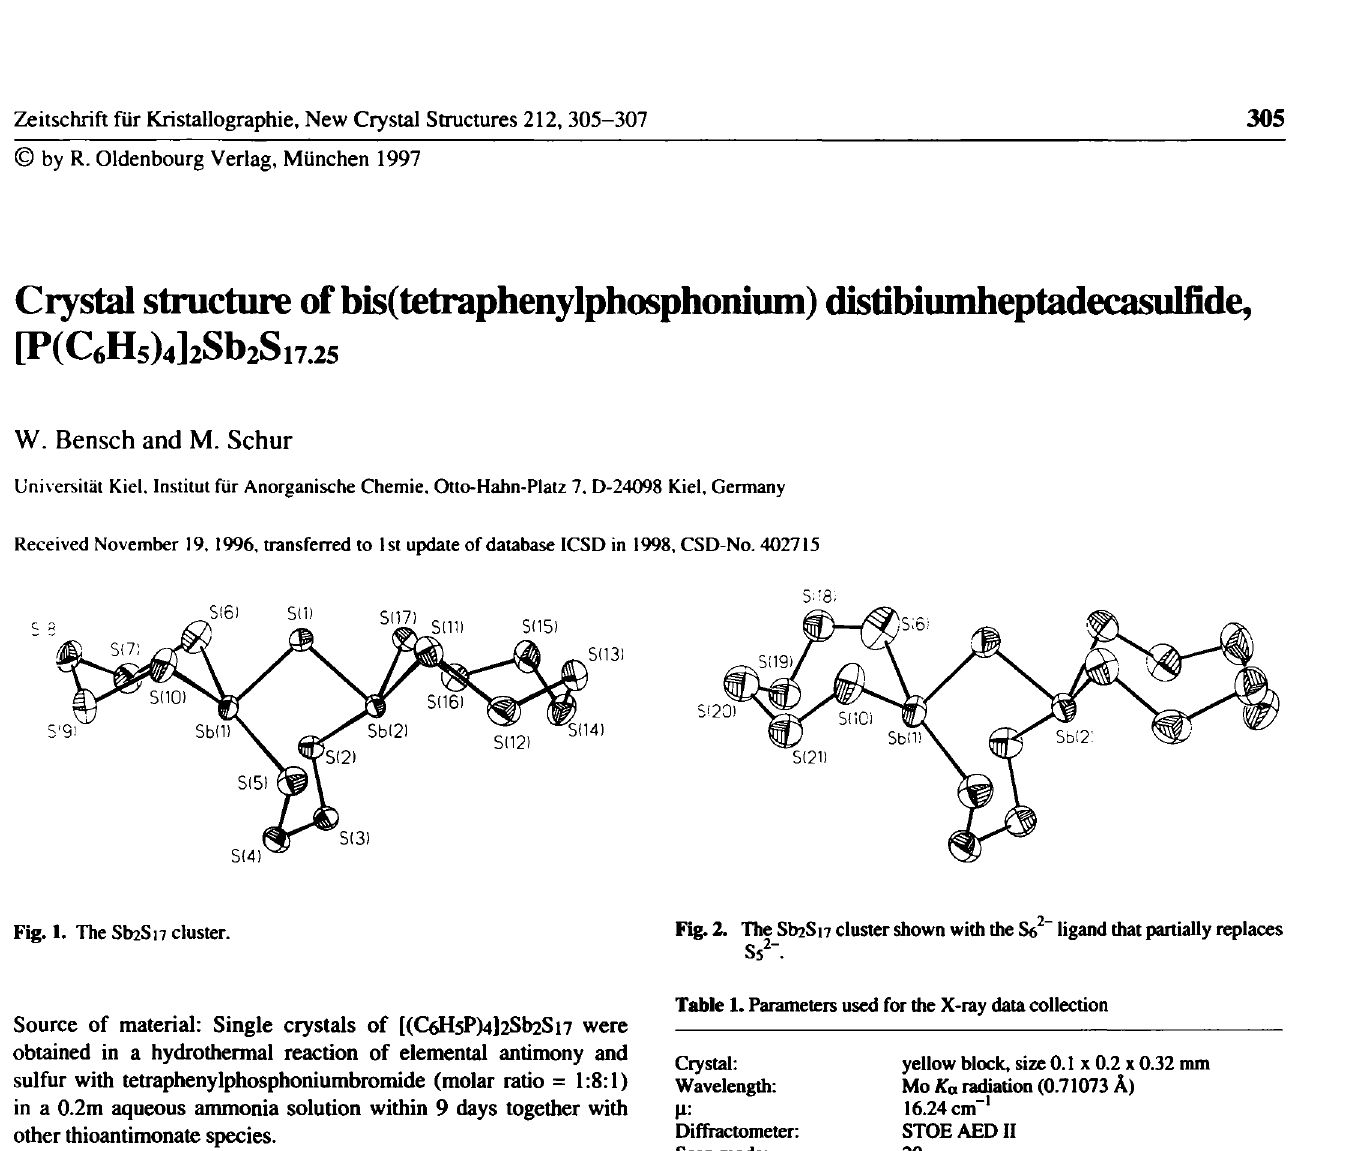
Table 2. Final atomic coordinates and displacement parameters (in A 2